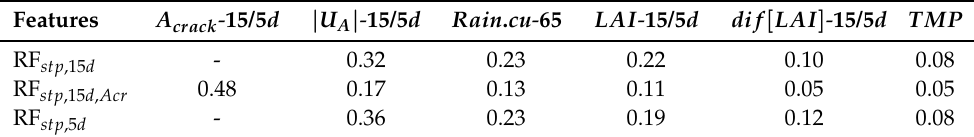
Table 5. Feature importance for short-term prediction RF models.